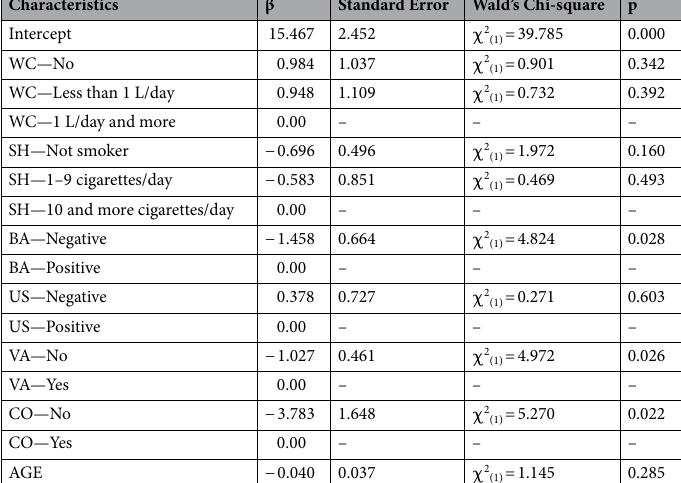
Table 6. Results of the generalized linear model with sperm apoptosis (AP) as response variable. WC wine consumption, SH smoking habit, BA semen bacteriological analysis, US urethral swab, VA varicocele, CO